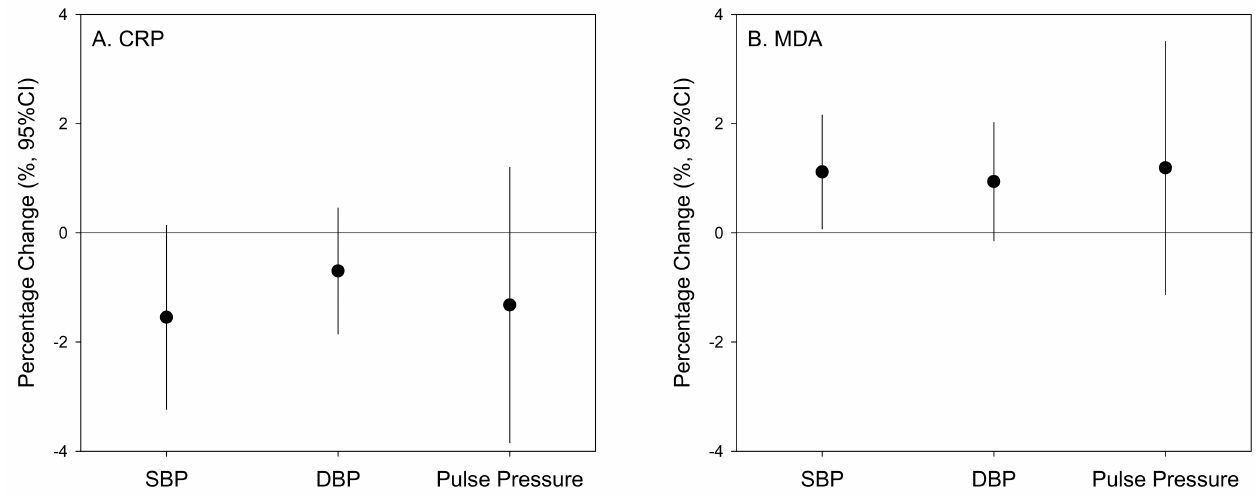
Figure 2. Percentage changes of blood pressure measures associated with a 1-SD increment in the natural logarithm of CRP (1.30, panel A ) and MDA (0.89, panel B ) concentrations in DBS samples. Associations were tested using linear mixed effects models with random intercepts for study participants, adjusted for the fixed effects of secondhand smoke exposures, respiratory symptoms (cough, chest tightness, and breath difficulty) in the past 2 weeks, time of the day, and the other DBS biomarker (CRP or